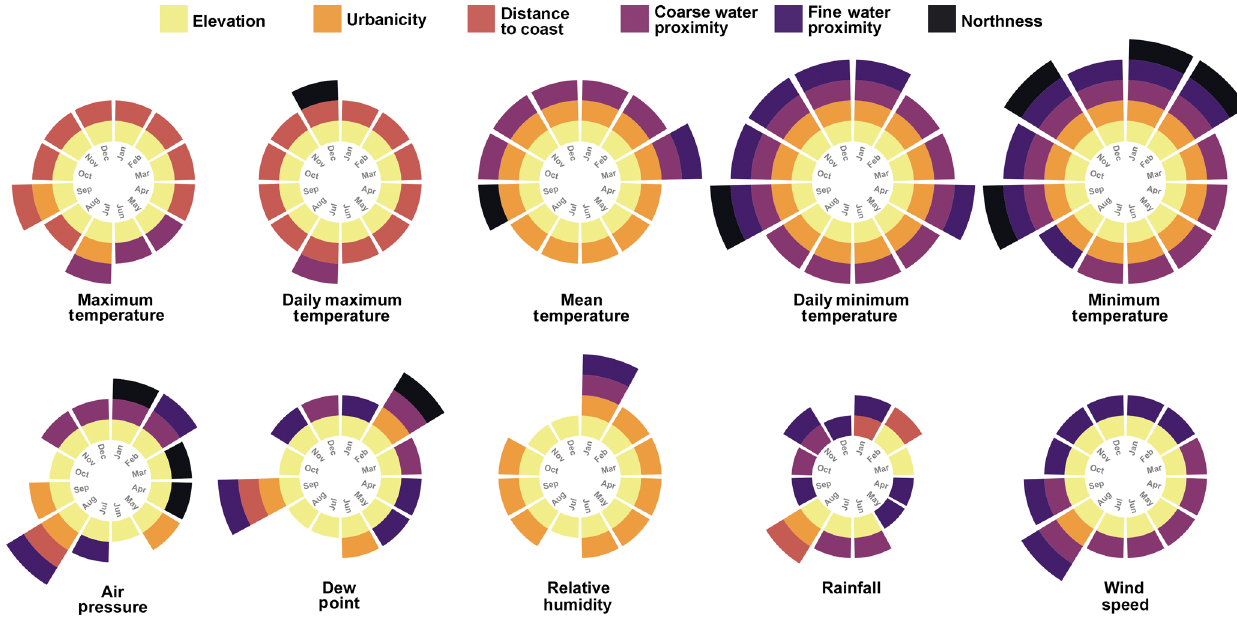
Figure 6. Regression predictors included in monthly models for 10 climate variables. Each predictor is represented by a different color. Minimum and mean temperature variables were most predictable, consistently including elevation and urbanicity. Rainfall patterns were most difficult, with the fewest predictors included.